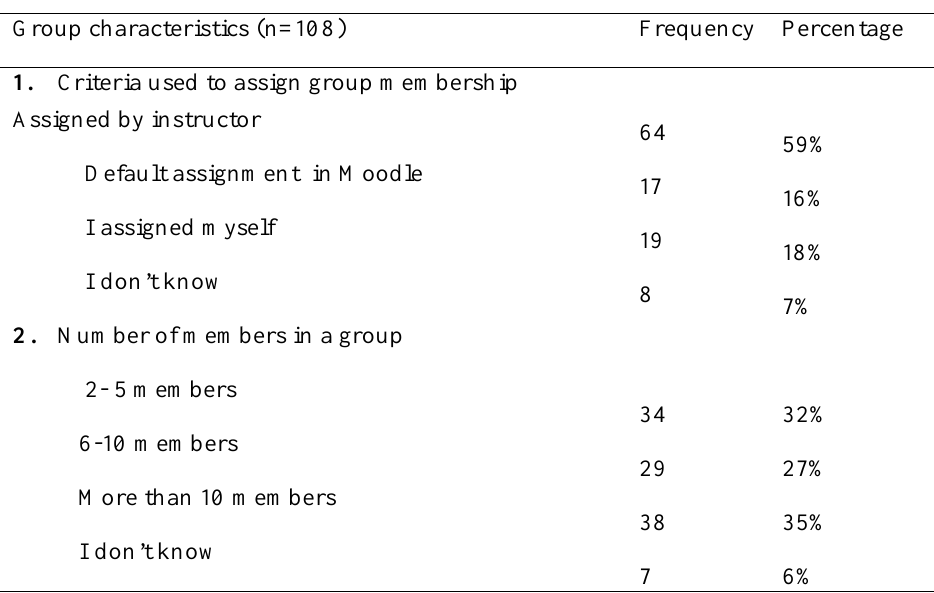
Frequency on Group Assignment Method and Group Sizes Group characteristics (n=108) Frequency